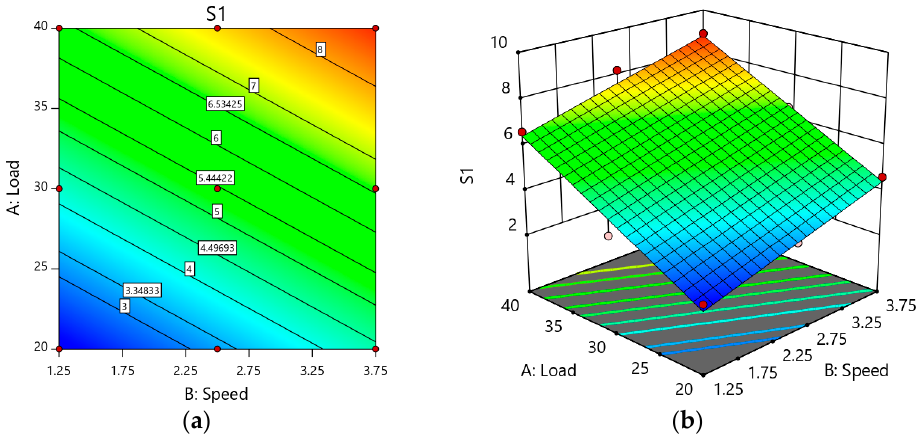
Figure 10. ( a ) 2D Response surface plot effect of load and speed on the weight loss of Sample S; ( b ) 3D Response surface plot effect of load and speed on the weight loss of Sample S1.